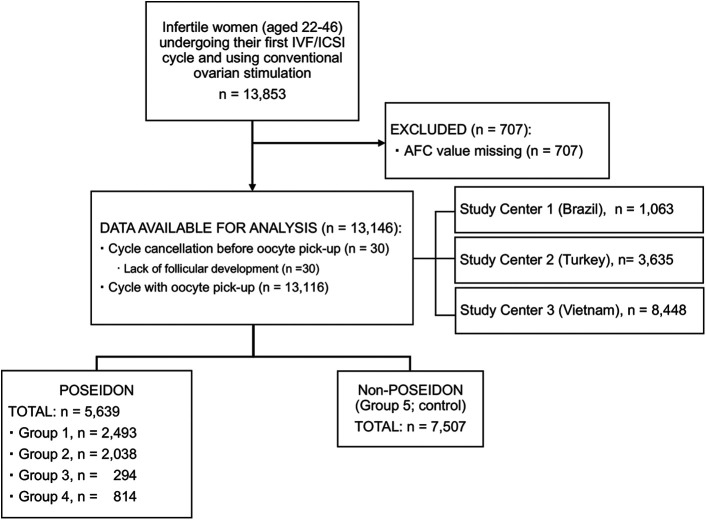
Flow diagram showing total patient breakdown.